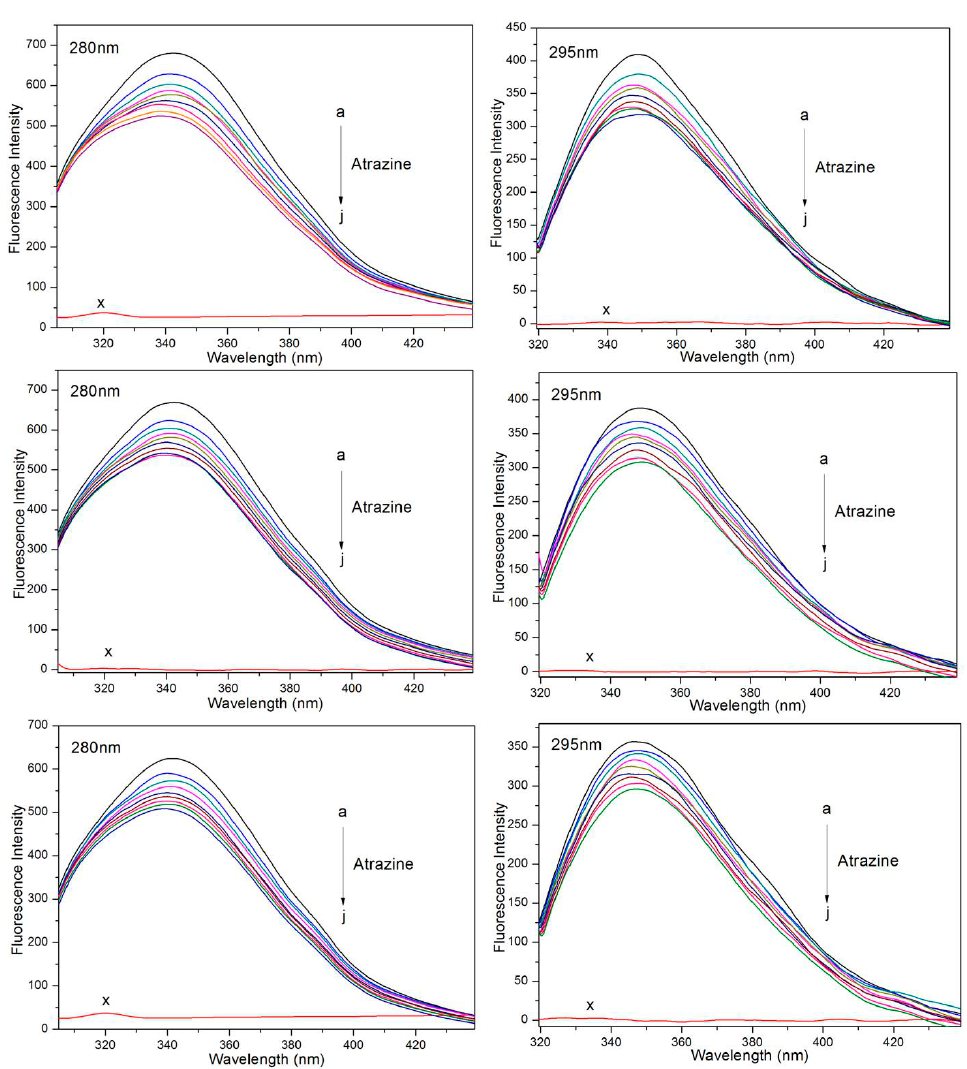
Figure 1. Steady ‐ state fluorescence spectra of HSA in the presence of different concentrations of ATR at three different temperature (298 K, 307 K and 316 K). (a–j) 0, 0.3, 0.6, 0.9, 1.2, 1.5, 1.8, 2.1, and 2.4 × 10 − 6 mol/L respectively. (x) only ATR.